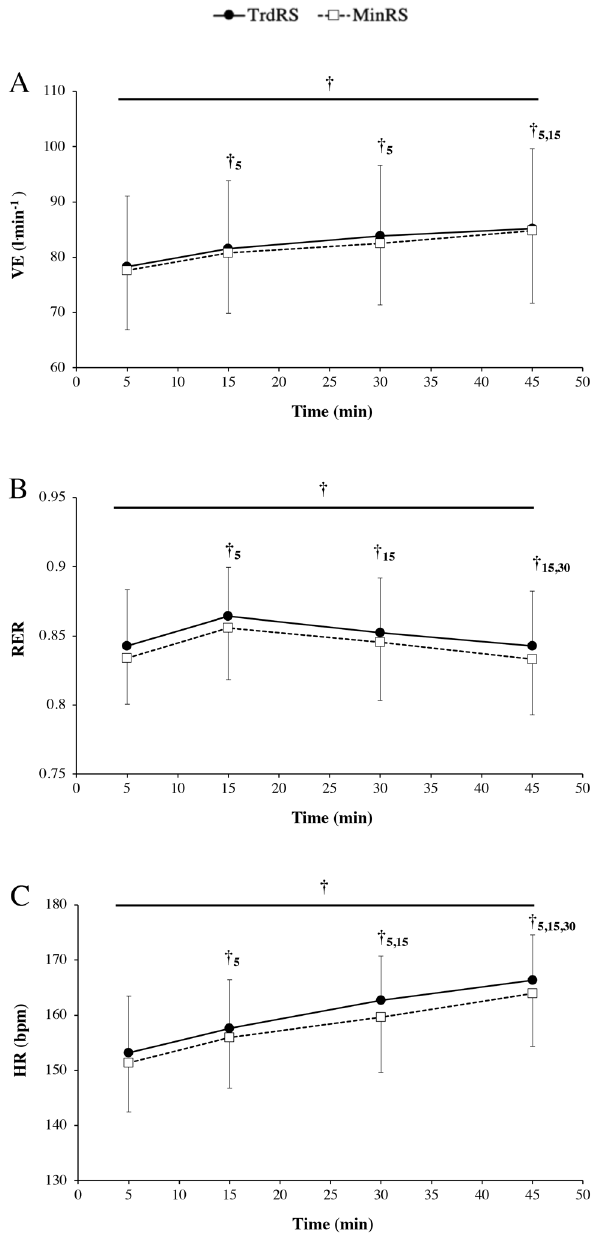
Figure 2. Ventilation ( A ), respiratory exchange ratio (RER) ( B ) and heart rate ( C ) versus time during the two experimental conditions [traditional cushioned (TrdRS) and minimalist (MinRS) running shoes]. Values are mean ± SD (n = 16). † indicates a significant time effect ( P ≤ 0.05); † 5 denotes a significant difference from 5 min; † 15 represents a significant difference from 15 min; † 30 indicates a significant difference from 30